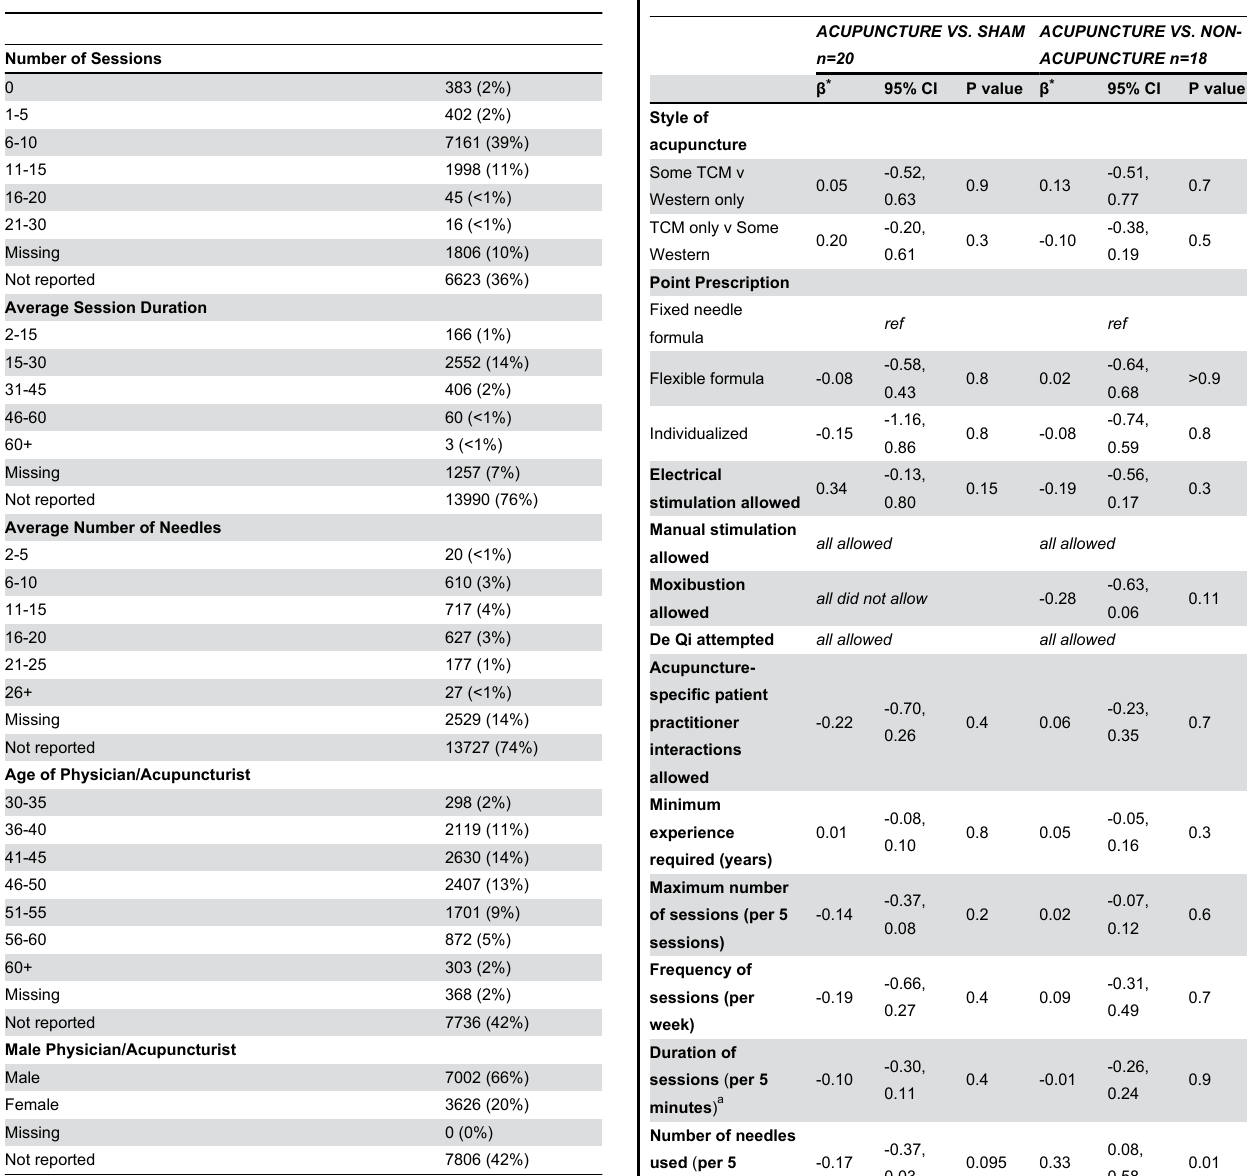
2. characteristics. Table 3. Results of univariate meta-regression